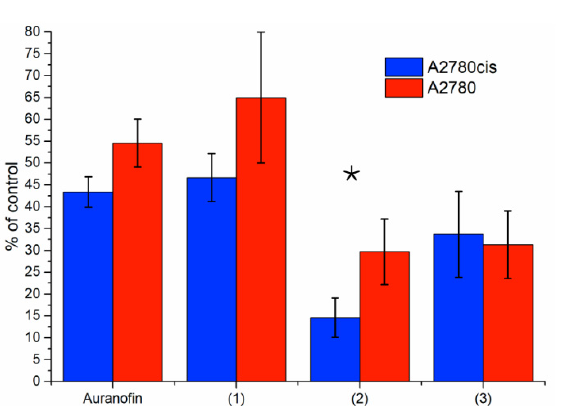
Figure 7. Inhibition of the activity of NADPH-dependent reductases in cytosol of A2780 and A2780cis cells by gold(I) phosphine complexes expressed as a % of control. Studied compounds were added at final concentration 10 µM. DMSO was added to the control samples as a solvent. Data represent the mean ± SD of three independent experiments. * Difference between mean values of % of inhibition determined in A2780 and A2780cis cells is statistically significant ( p < 0.05).